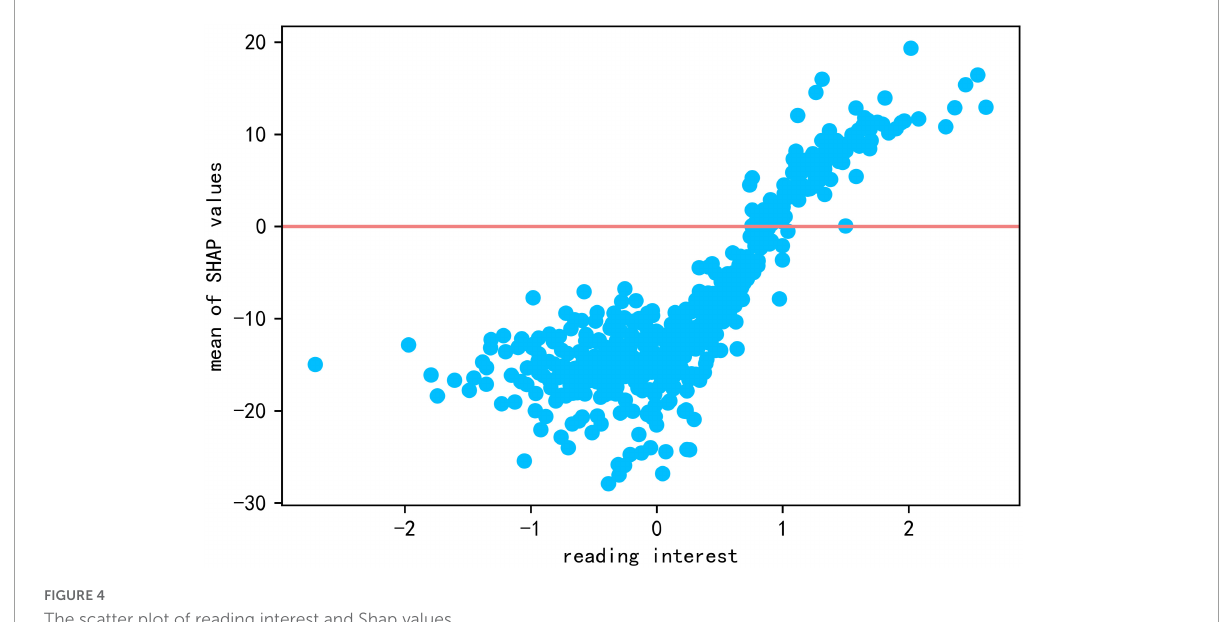
FIGURE4 The scatter plot of reading interest and Shap values.